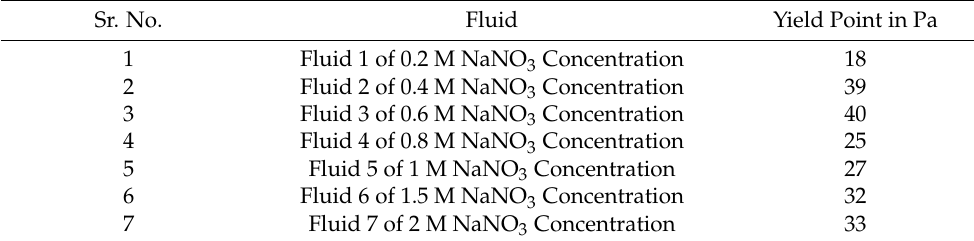
Figure 13. Shear stress vs shear rate curves for surfactant-based viscoelastic fluids of type2 with varying NaNO 3 concentrations at 25 °C.